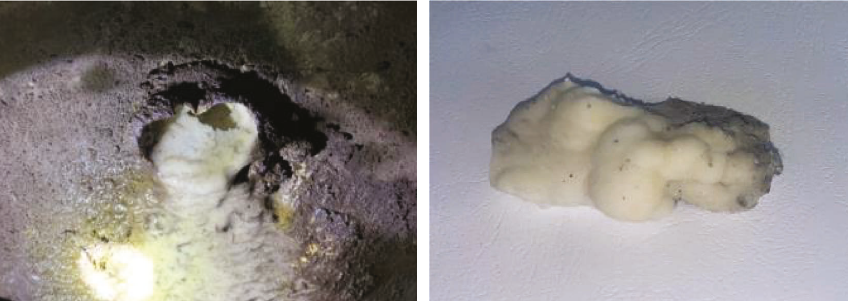
Figure 1: Macroscopic view of